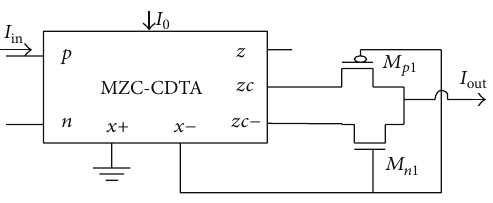
Figure 3: Proposed current mode